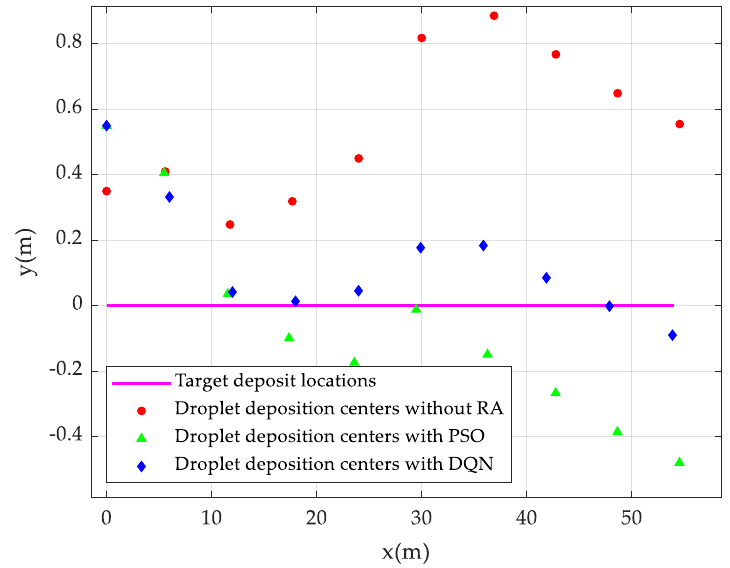
Figure 10. Positions of droplet deposition centers before and after route adjustments.